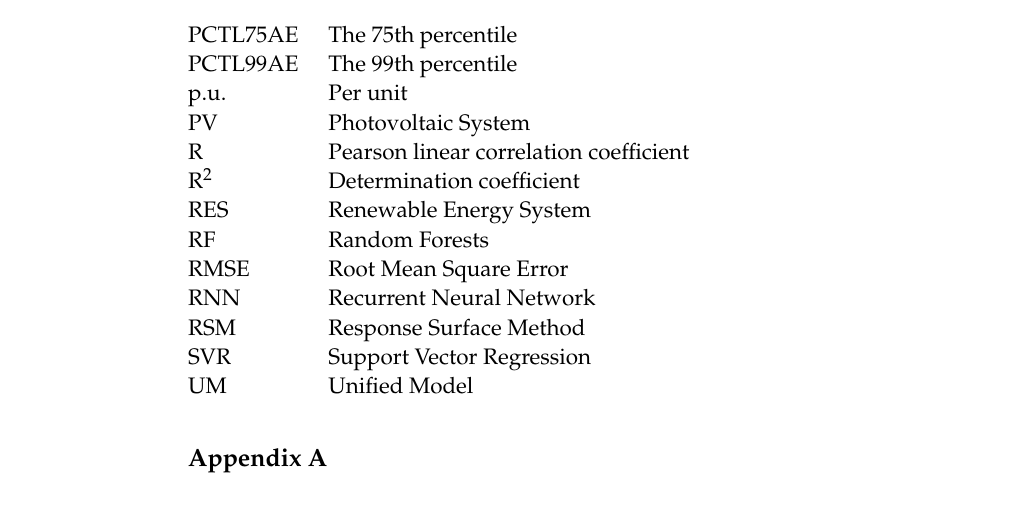
Table A1. The results of hyperparameters tuning for hybrid methods and ensemble methods based on hybrid methods. Method